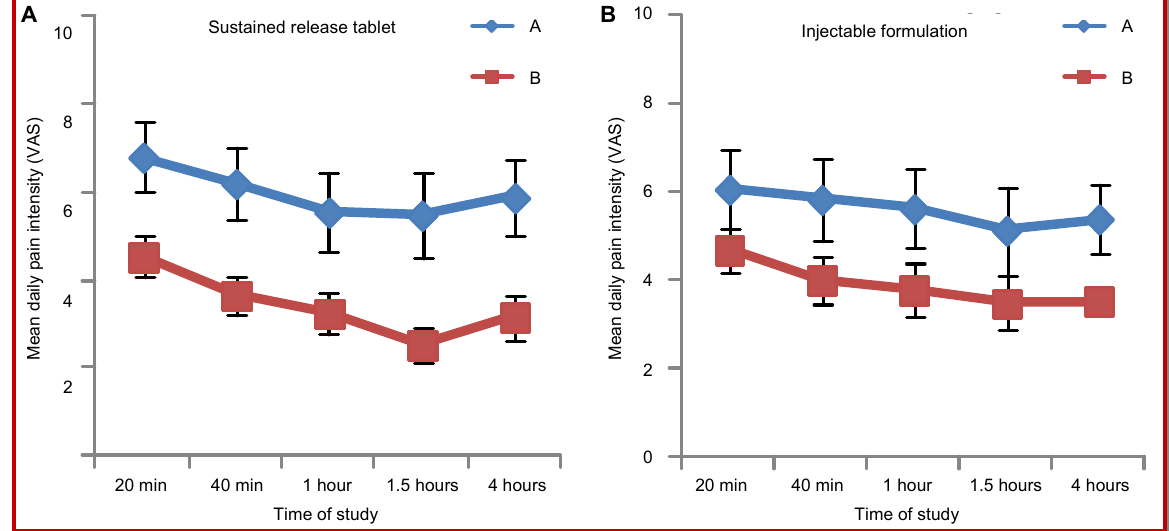
Figure 1 : Estimation of morphine in solution prepared from sustained release tablets and injectable formulation without and with added preservative stored at different temperature and time Solution prepared by sustained release tablet- without (a) or with (b) added preservative stored in room temperature (20-25°C); without (c) or with (d) added preservative stored 4°C temperature. Solution prepared by injectable formulation - without (e) or with (f) added preservative stored in room temperature (20-25°C); without (g) or with (h) added preservative stored 4°C temperature